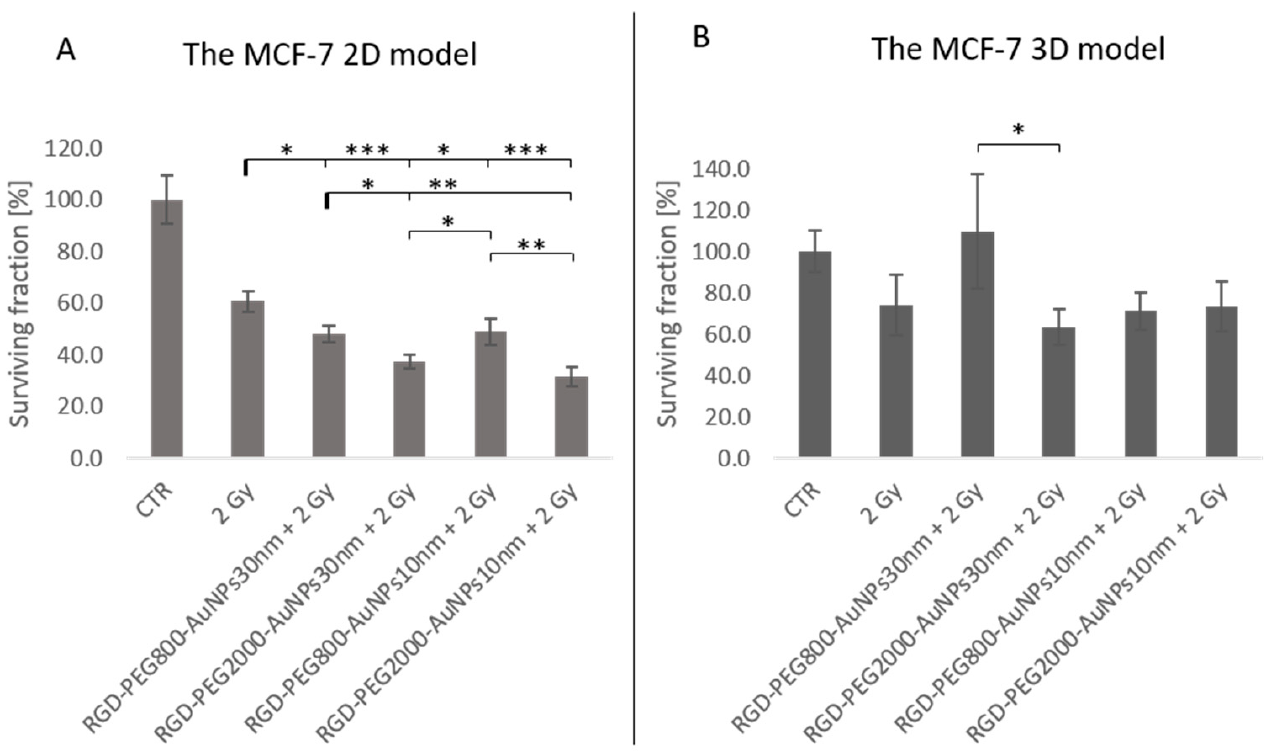
Figure 8. The survival fraction of MCF-7 cells after exposure to a dose of 2 Gy and dose of 2 Gy with the previous 50 min incubation with RGD-PEG 800 -AuNPs 10nm, and RGD-PEG 2000 -AuNPs 10nm , RGD- PEG 800 -AuNPs 30nm , and RGD-PEG 2000 -AuNPs 30nm in the concentration of 0.0008 mg/mL. ( A ) Results for the MCF-7 2D model and ( B ) for the MCF-7 3D model. The setting of the p-value * p < 0.05, ** p < 0.01, *** p < 0.001.